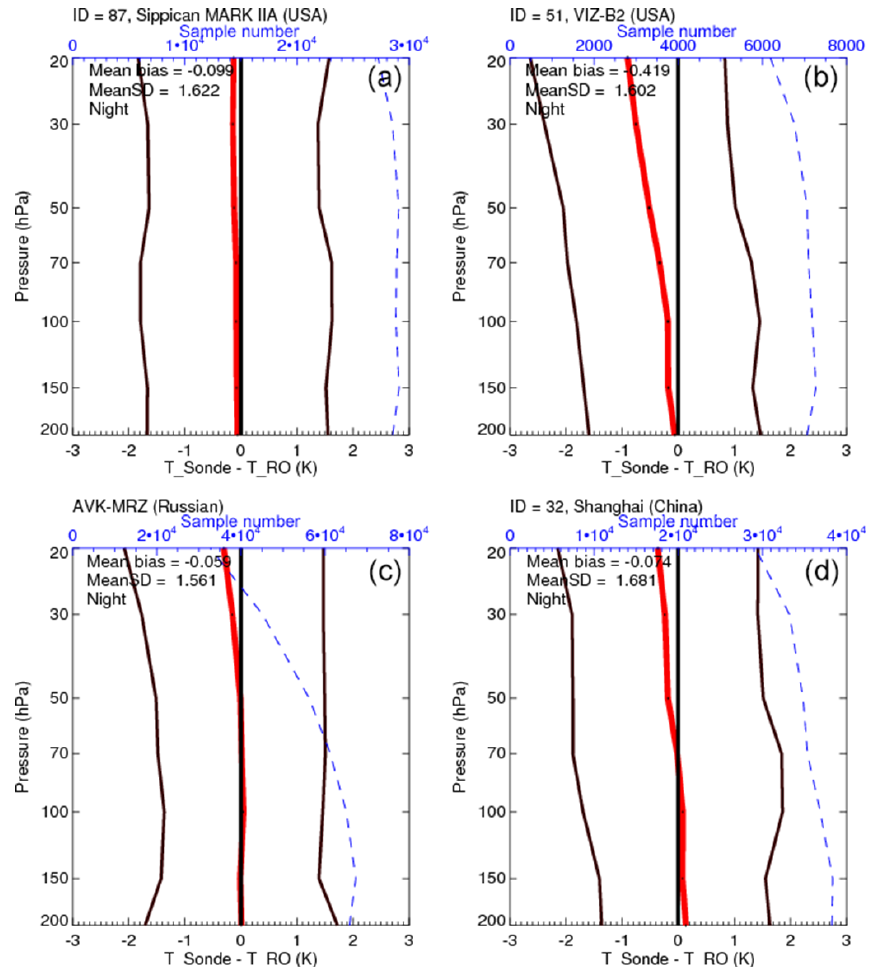
Figure 7. Comparisons of temperature between radiosonde and RO during the nighttime for (a) Sippican over United States minus RO, (b) VIZ-B2 over United States minus RO, (c) Russian sonde minus RO, and (d) Shanghai minus